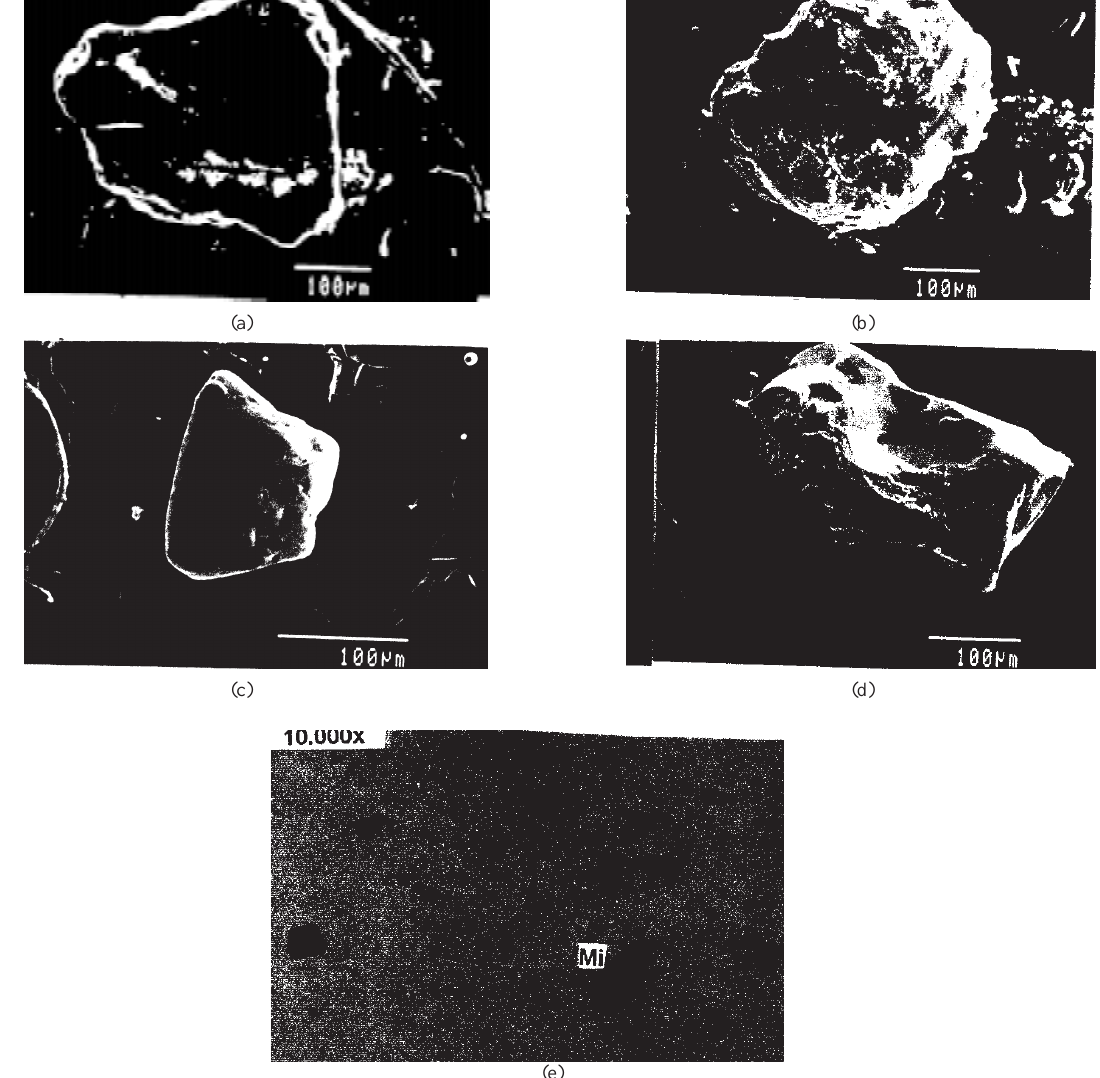
Figura 3. Fotomicrografias (MEV) de partículas de biotita (a), agregado de caulinita e óxido de ferro (b), agregado de sílica (c) e óxido de Ti e Fe (d) na fração areia na profundidade de 2,1 m e partícula de biotita (e) na fração argila (MET) na profundidade de 5,6 m, em sedimentos do Grupo Barreiras no município de Aracruz